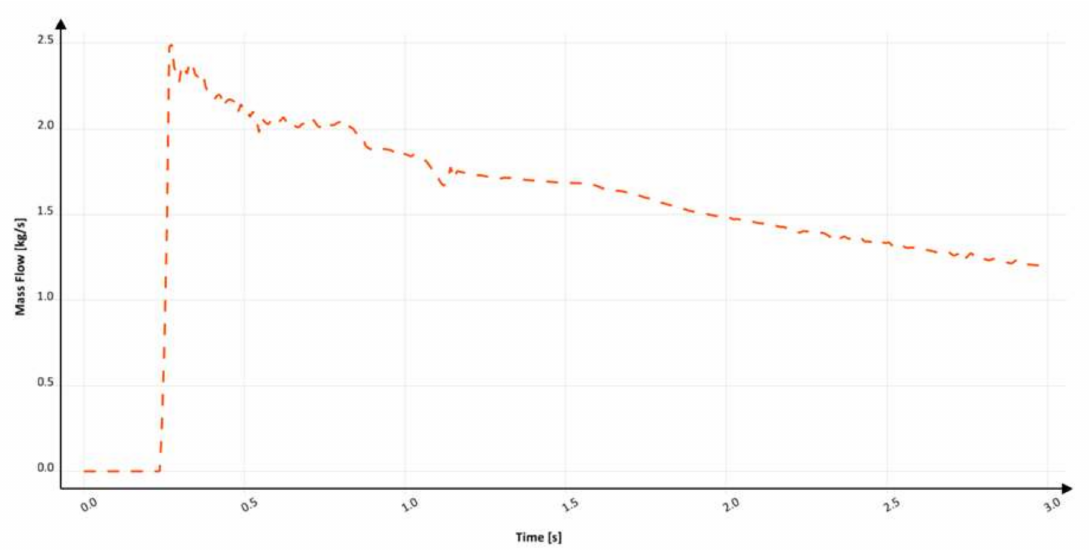
Figure 29. Mass flow through an ingate with round sprue with hyperbolic taper (S s 6), MAGMASOFT.